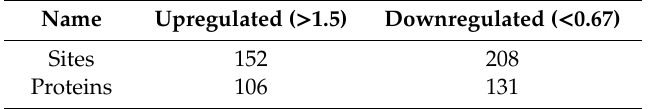
Table 1. Summary of di ff erentially quantified sites and proteins after